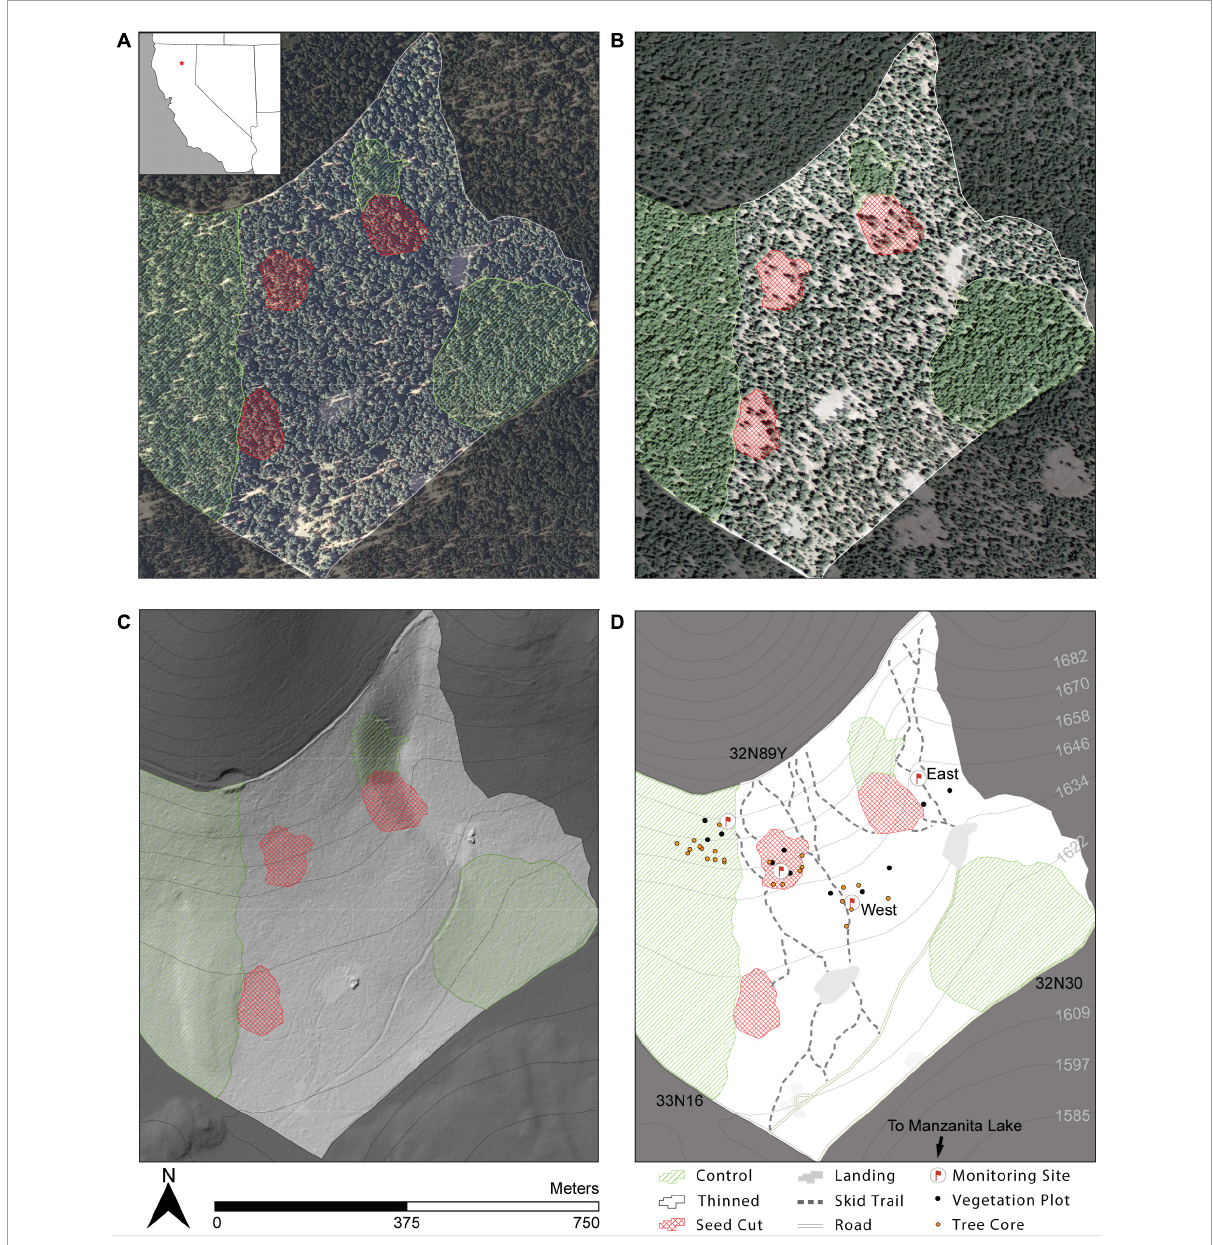
FIGURE3 Unit 321 of the Panner Timber Sale (40.6 ◦ N, 121.5 ◦ W), both (A) before (Aug 4, 2010) and (B) after (July 3, 2012) the 2011 timber harvest [National Agricultural Imagery Program (NAIP), Manzanita Lake NE Digital Orthophoto Quarter Quadrangle (DOQQ), published by USDA Farm Service Agency Aerial Photography Field Office, Salt Lake City UT]. (C) One-meter LiDAR bare Earth DEM hillshade showing site topography (Burney–Hat Creek Basins CFLR Project Data, Lassen National Forest; acquired 2015). (D) Locations of stand treatments, forest infrastructure, study instrumentation, and vegetation plot sites. West and East locations of the Thinned monitoring sites are labeled (all discussion in the text refers to the West site unless Thinned-East is specified). Contour interval is 12.19 meters, and displayed elevations are rounded to the nearest meter. Public Land Survey System (PLSS): T: 32 N, R: 4 E, S: 20 and 29, Mount Diablo Meridian. Hat Creek Ranger District, Lassen National Forest; Shasta County, California, United